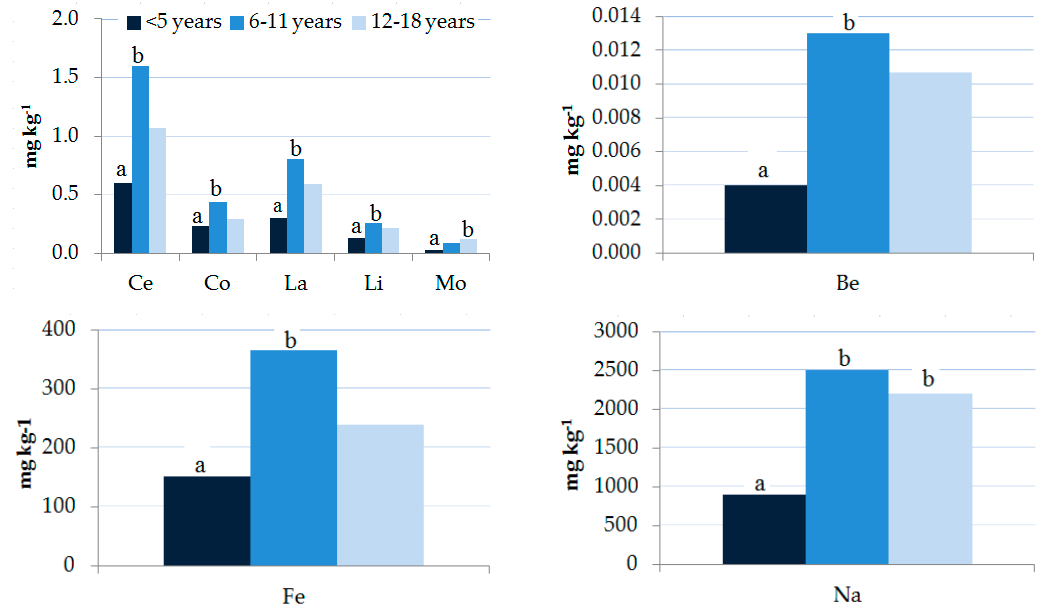
Figure 6. Influence of age on element levels (geometric mean, mg kg − 1 ) in children’s hair samples. A non-parametric Kruskal–Wallis test was applied. Different letters “a” and “b” for the same element show significant differences ( p < 0.05).